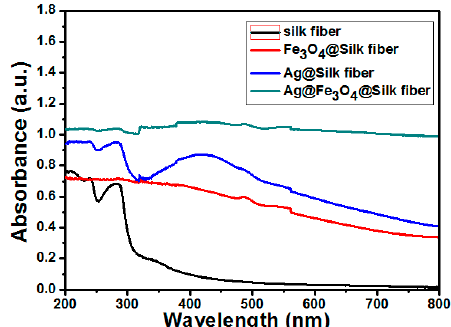
Figure 3. UV-vis spectrum of the silk fibers, Fe 3 O 4 –silk fibers, Ag–Fe 3 O 4 –silk fibers (2#), and Ag–Silk fibers (2#).